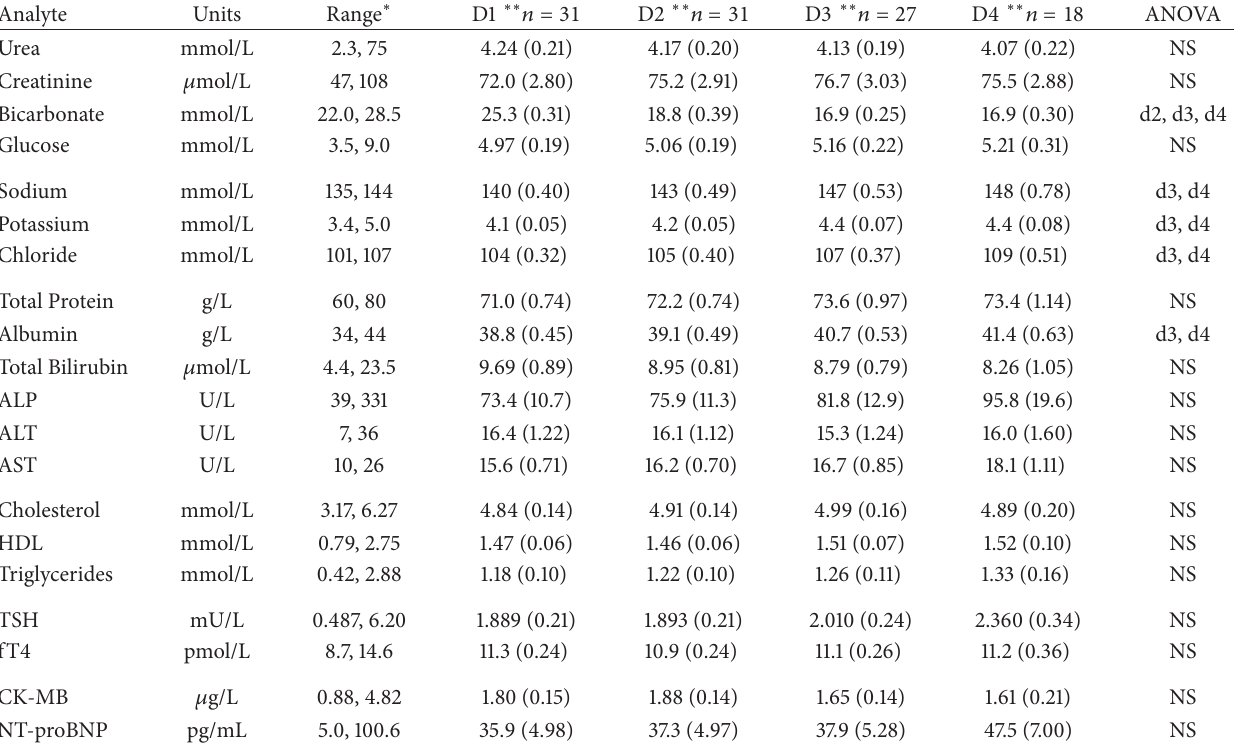
Table 4: Stability of serum in RSTs over 4 days indicated by repeat